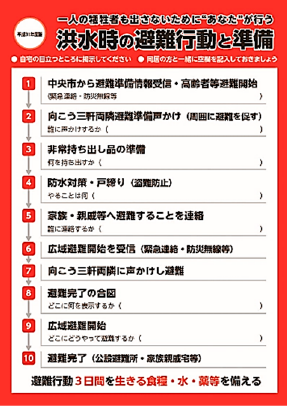
Figure 7. My timeline for each household printed by the residents‘ associations.